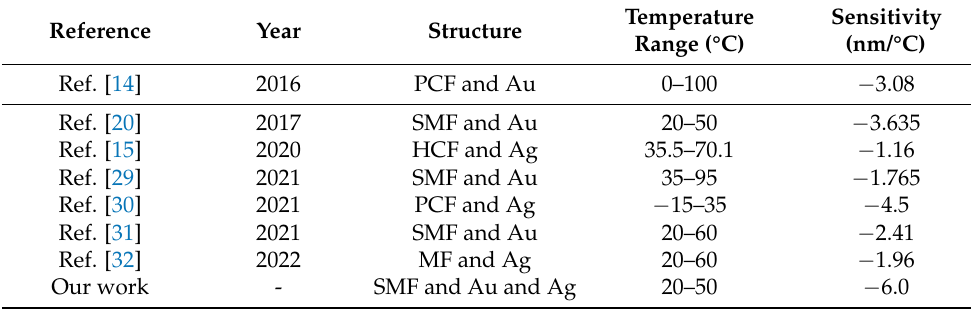
Table.2 Comparison table of performance parameters.